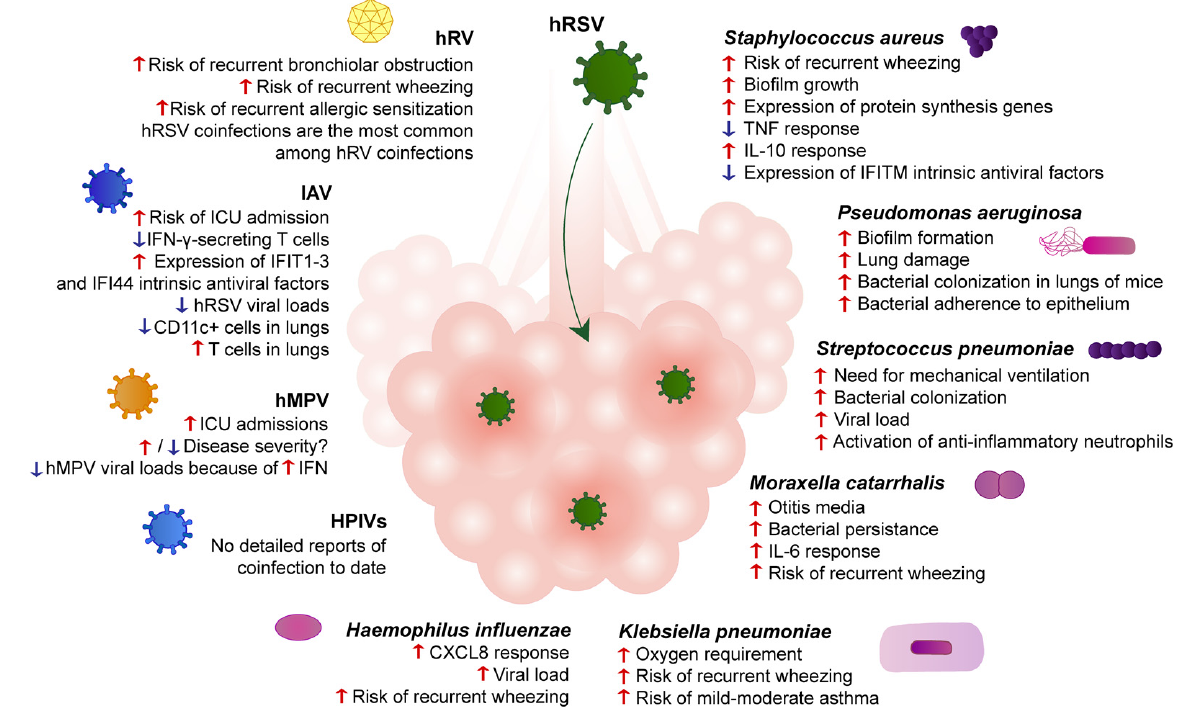
Figure 1. hRSV coinfections with bacteria and viruses modulate lung pathogenesis and clinical outcomes. Bronchi are depicted during infection with hRSV. Descriptions beneath the bolded name of each pathogen represent differences between the coinfection between hRSV and the respective pathogen and hRSV single-infection. Red arrows represent an upregulation or more marked response. Blue arrows represent a downregulation or diminished response.